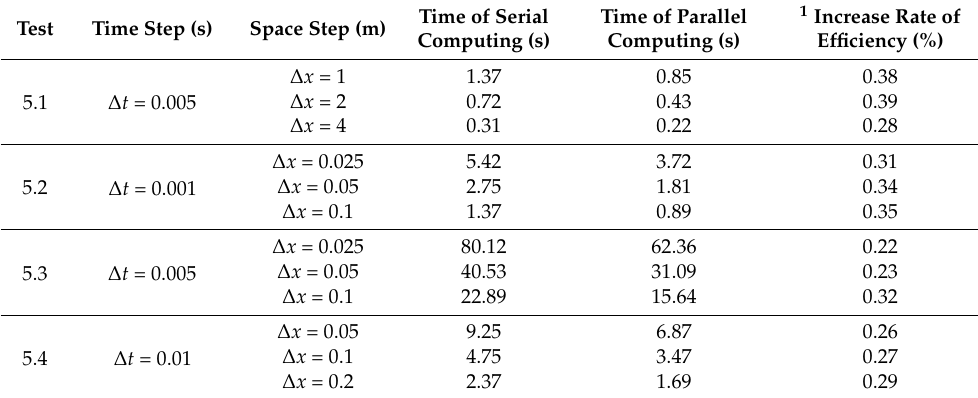
Table 1. CPU time of serial computing and parallel computing (four tests).